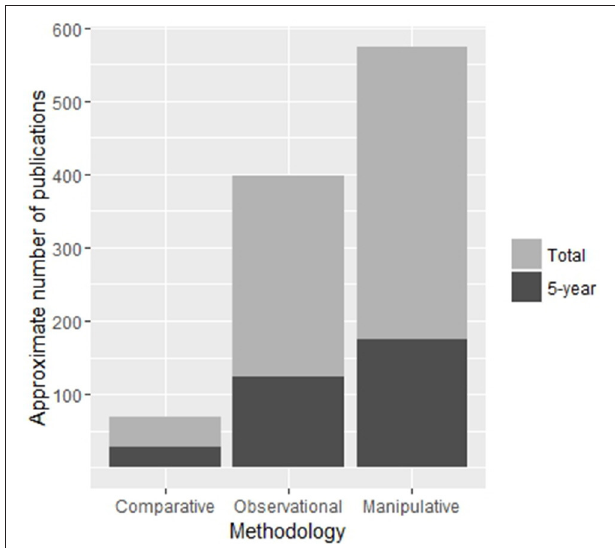
FIGURE 3 | Approximate number of publications on cooperative breeding for each methodology. The number articles published in the last 5 years is shown in dark gray and is included in the total count. Search parameters are available in Supplementary Table S1. Numbers presented here are intended as approximations only as search parameters were not completely mutually exclusive or